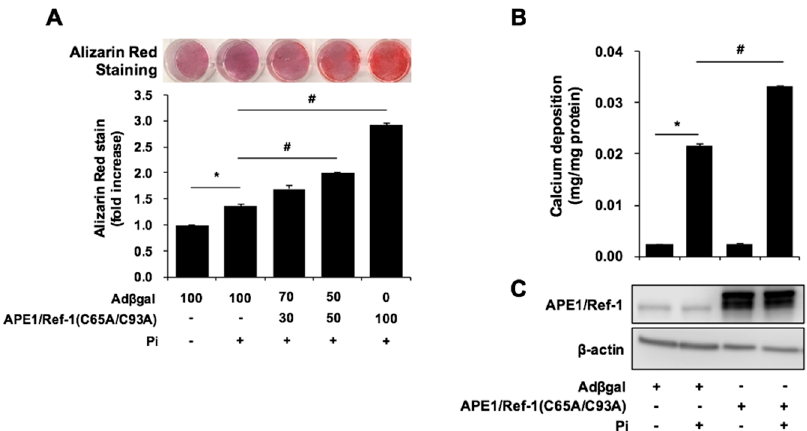
Figure 4. The APE1/Ref-1 redox mutant does not suppress inorganic phosphate (Pi)-induced calcification in vascular smooth muscle cells. ( A ) Alizarin red staining. ( B ) Calcium-deposition assay. Cells were transfected with APE1/Ref-1 C65A/C93A at a multiplicity of infection from 30 to 100 and exposed to Pi (5 mM) for 6 days. Each bar represents the mean ± standard error of the mean (SEM) ( n = 6). * p < 0.05 vs. control; # p < 0.05 vs. Pi alone by one-way ANOVA. ( C ) After adenoviral transfection, overexpression of APE1/Ref-1 C65A/C93A was confirmed by Western blot analysis. The redox mutant of hemagglutinin-tagged APE1/Ref-1 C65A/C93A was ~40 kDa, which was larger than that of endogenous APE1/Ref-1 (37 kDa).